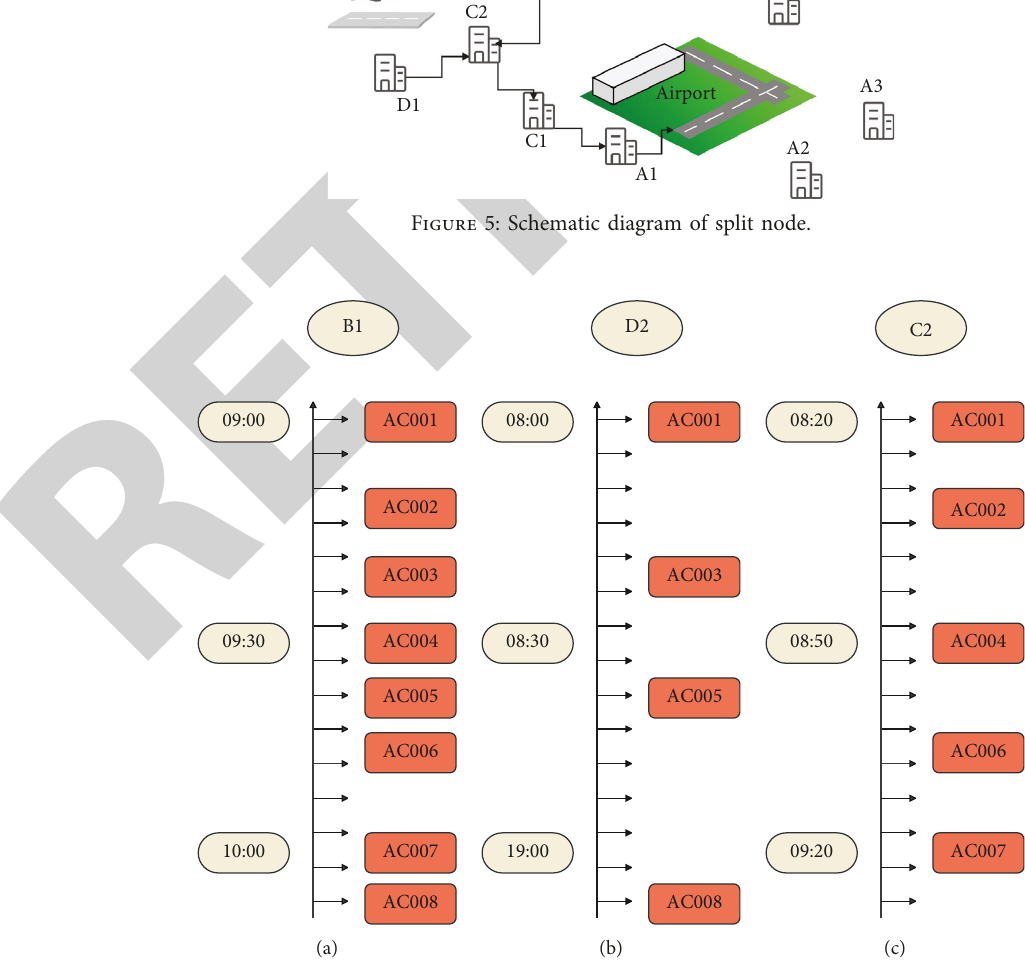
Figure 4: Control type of freezing zone.